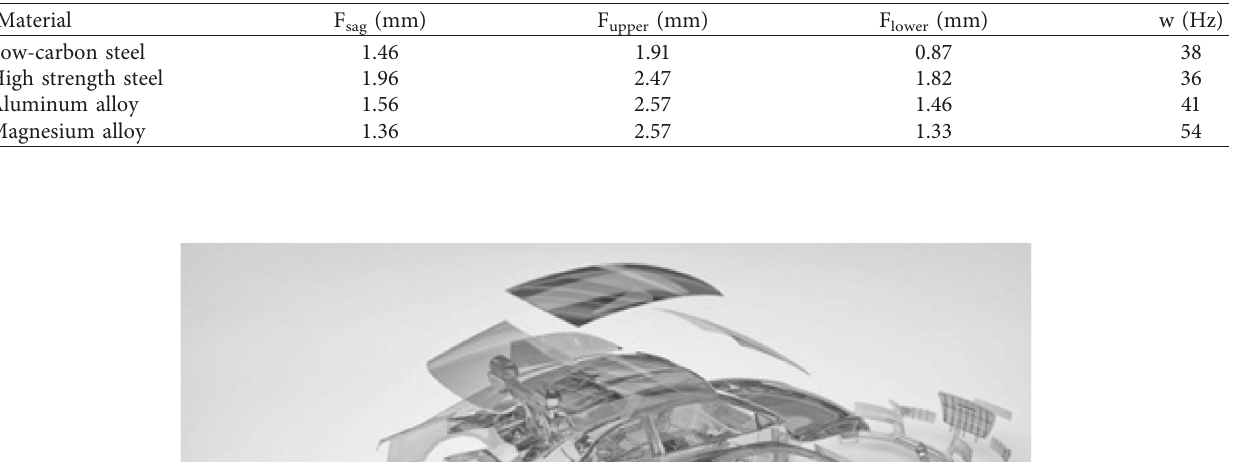
Table 3: Performance after structural optimization.